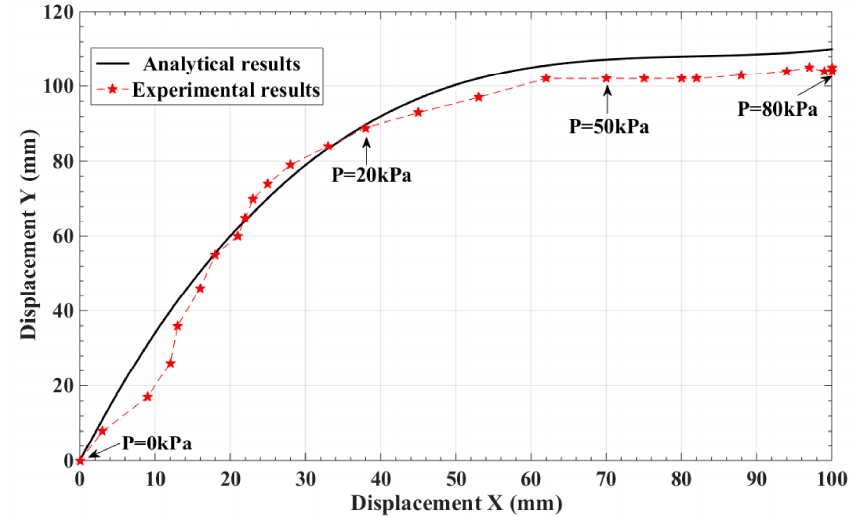
Figure 9. Motion trajectory of the actuator with different input pressure.